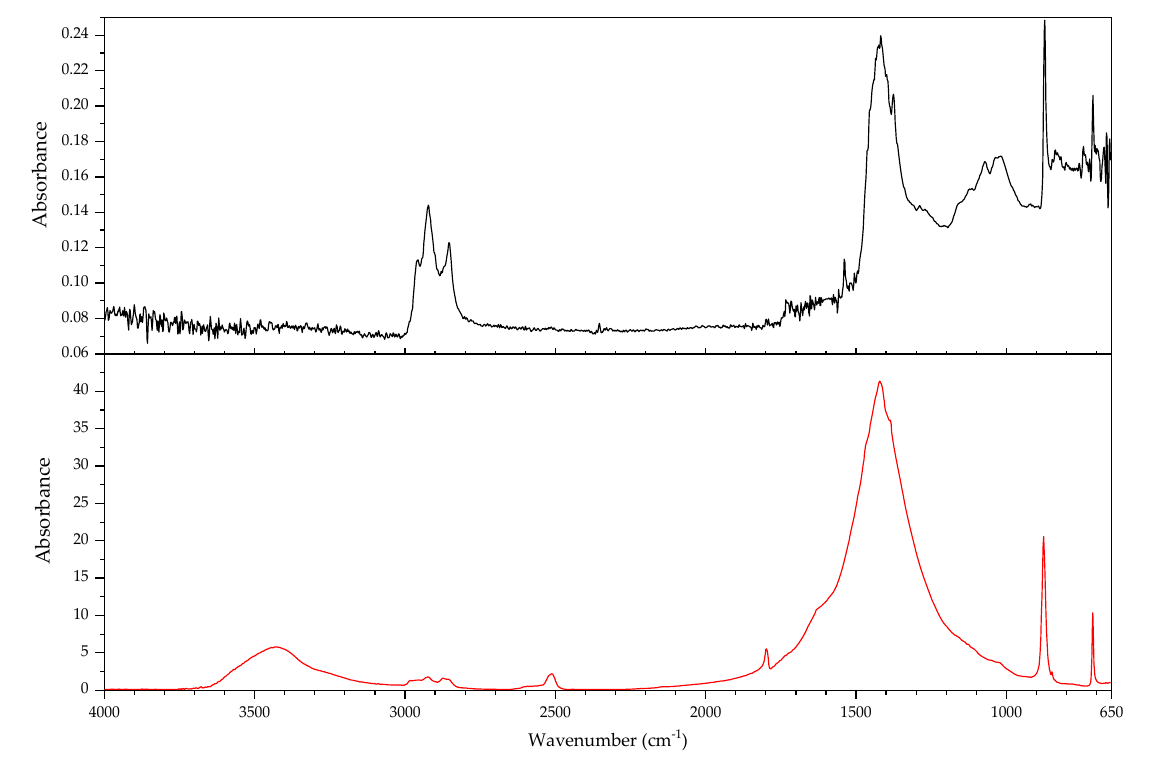
Figure 3. FTIR spectrum of sample 431 (black line) compared to reference spectrum of calcium carbonate (red line) from a commercial database.